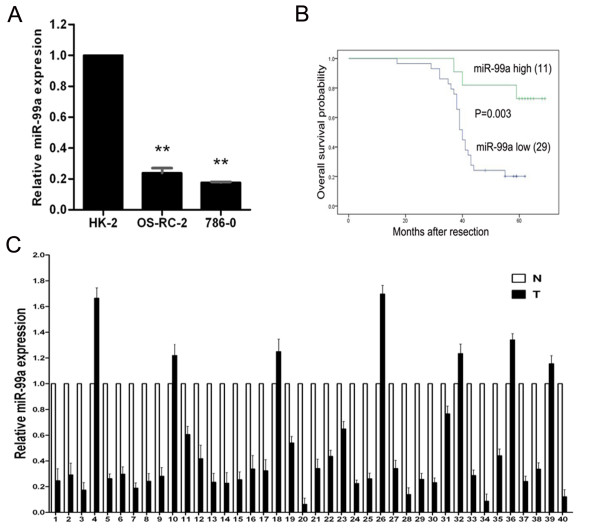
MiR-99a is downregulated in renal cell carcinoma. (A) Real-time qRT-PCR analysis of relative miR-99a expression levels in RCC cell lines (786-O and OS-RC-2) and normal immortalized renal cell line (HK-2). (B) Relative miR-99a expression levels in 40 pairs of RCC and their matched adjacent non-tumor tissues as assessed by real-time qRT-PCR. MiR-99a was considered to be significantly downregulated only if the calculated fold-change was less than 0.5 in the tumor tissue compared with the matched adjacent non-tumor tissue. (C) Correlation of miR-99a expression with overall survival in RCC patients. Overall survival of RCC patients were analyzed by Kaplan-Meier analysis in SPSS 17.0. Relative miR-99a level was assessed by real-time qRT-PCR and T/N = 0.5 was chosen as the cut-off point for separating miR-99a high-expression tumors (n = 11; T/N > 0.5) from miR-99a low-expression cases (n = 29; T/N < 0.5). Data were normalized to U6 control and are represented as mean ± standard deviation (SD) from three independent experiments. T means RCC tissues. N means matched adjacent non-tumor tissues. **, P < 0.01.